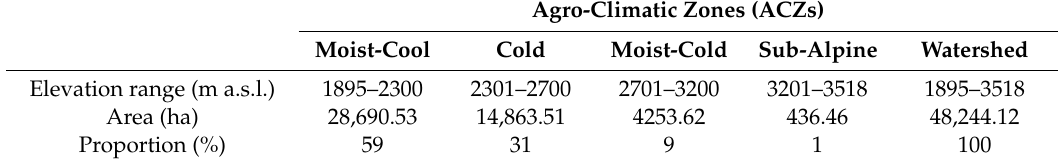
Table 1. Area coverage of the agro-climatic zones (ACZs) of the Jema watershed as computed from the digital elevation model with a 30-m